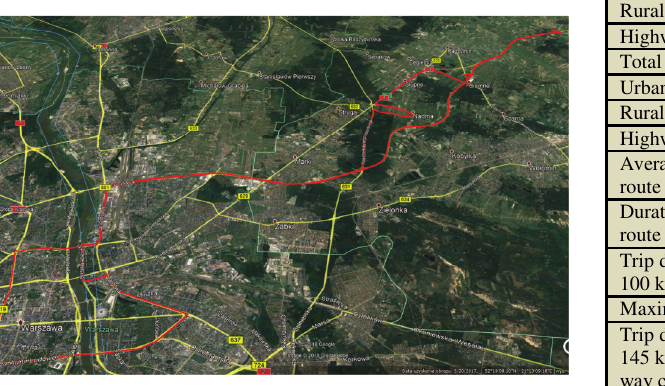
Fig. 2. Course of the designated RDE route